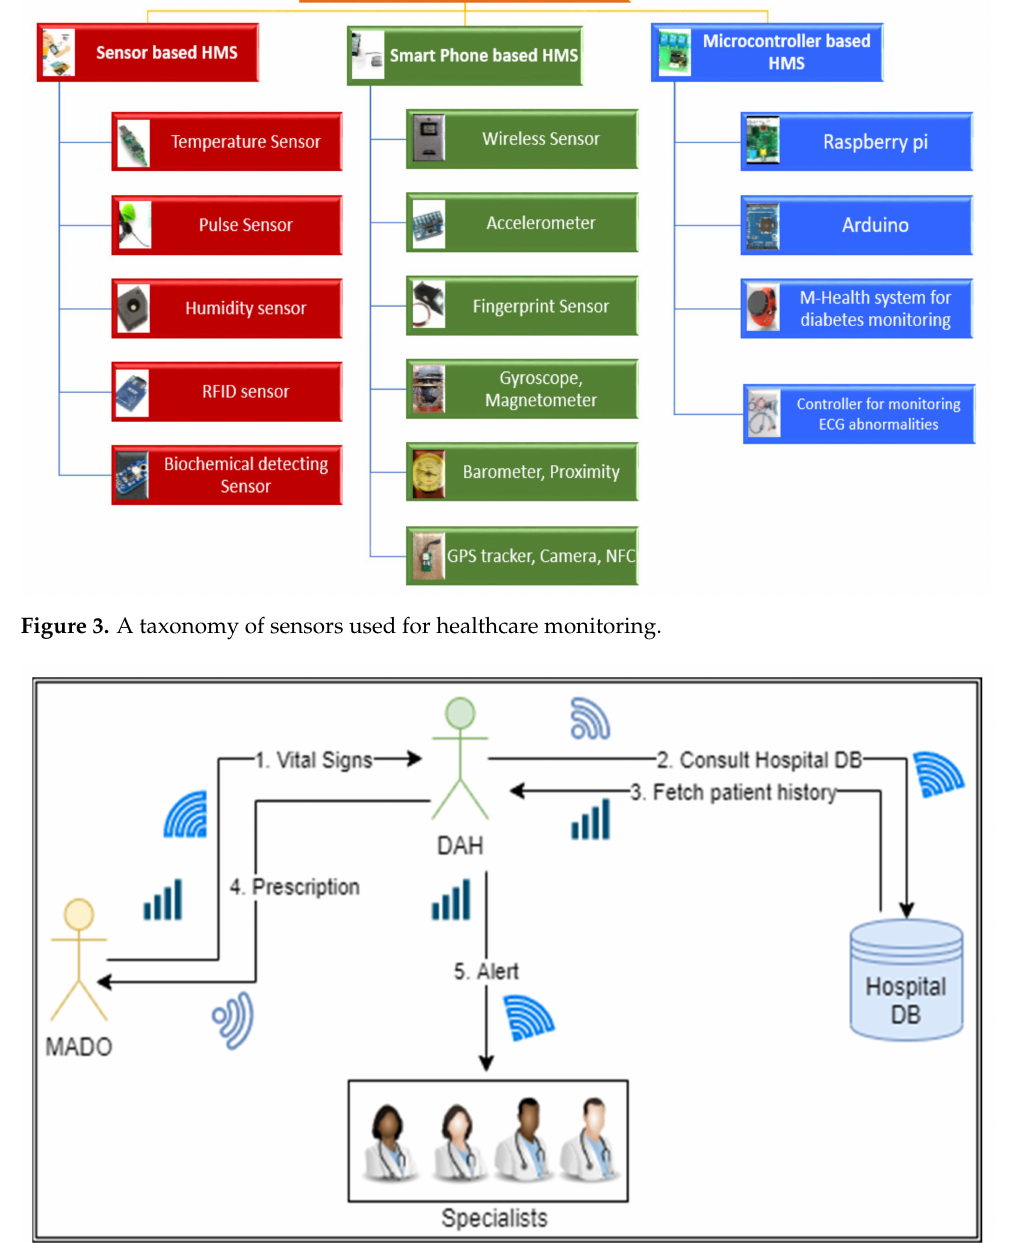
Figure 4. Role of DAH in providing healthcare